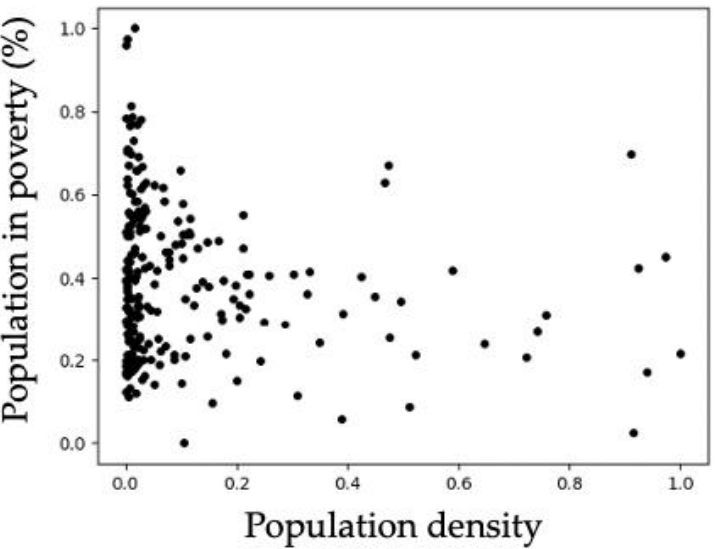
Figure 2. Distribution of municipalities by population density and poverty percentage. Table 4. Results of the clustering.